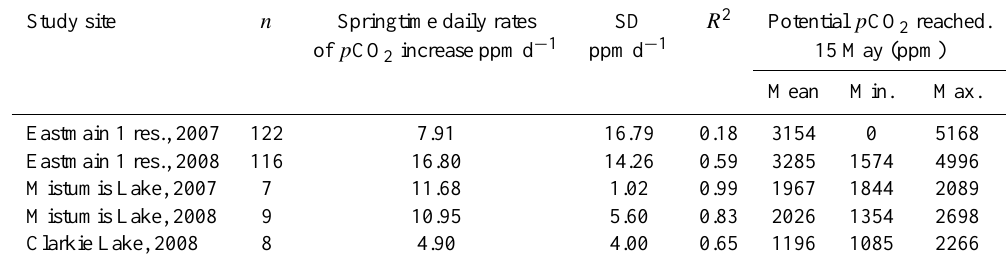
Table 4. Daily rates of under-ice p CO 2 increase and maximum potential p CO 2 reached by 15 May at study sites. Study site n Springtime daily rates SD R 2 Potential p CO 2